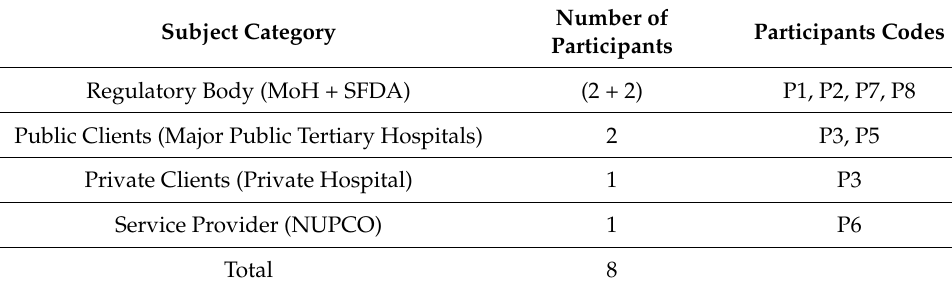
Table 3. Number of Participants per Category at All